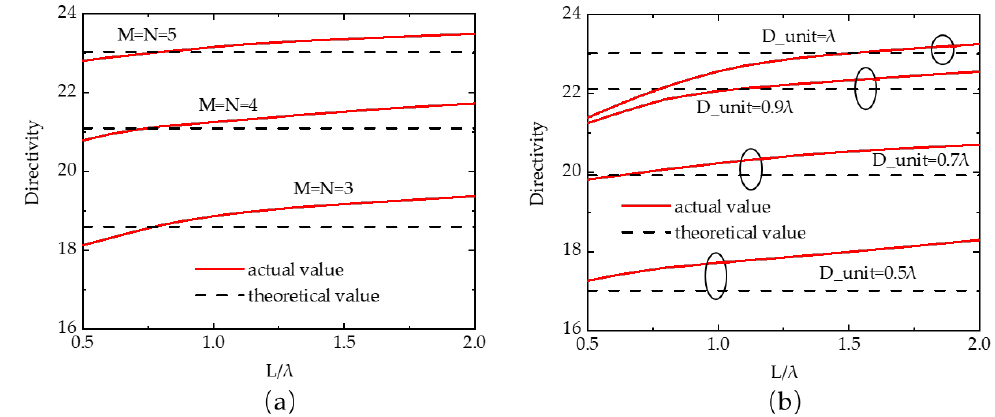
Figure 1. Directivity of a uniform rectangular array with different length of the element: ( a ) equal element spacing ( D _ unit = 0.8 λ ) along the axes ( x , y ), ( b ) equal element number ( M = N = 4 )